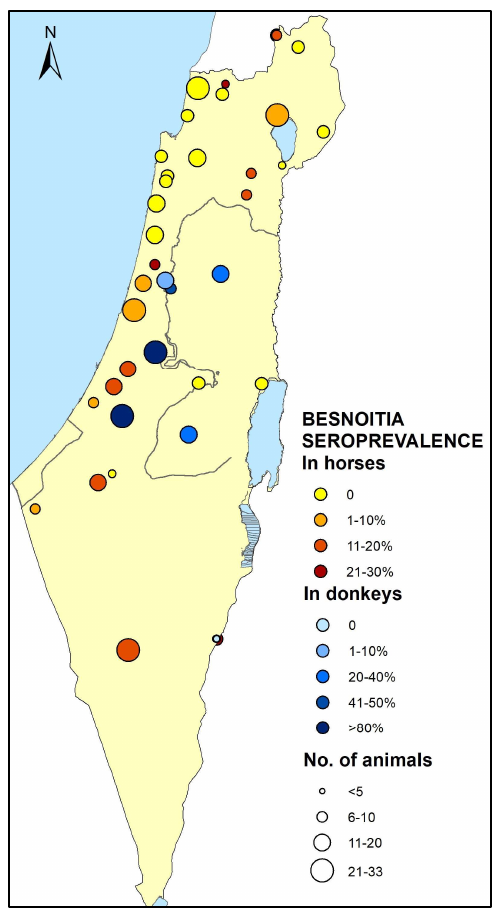
Figure 1. The geographical distribution of the study population, and Besnoitia seroprevalence at each farm. Horse farms appear in red and donkey farms in blue. The size of each circle represents the number of animals sampled, while the intensity of the color reflects Besnoitia seroprevalence at each farm.